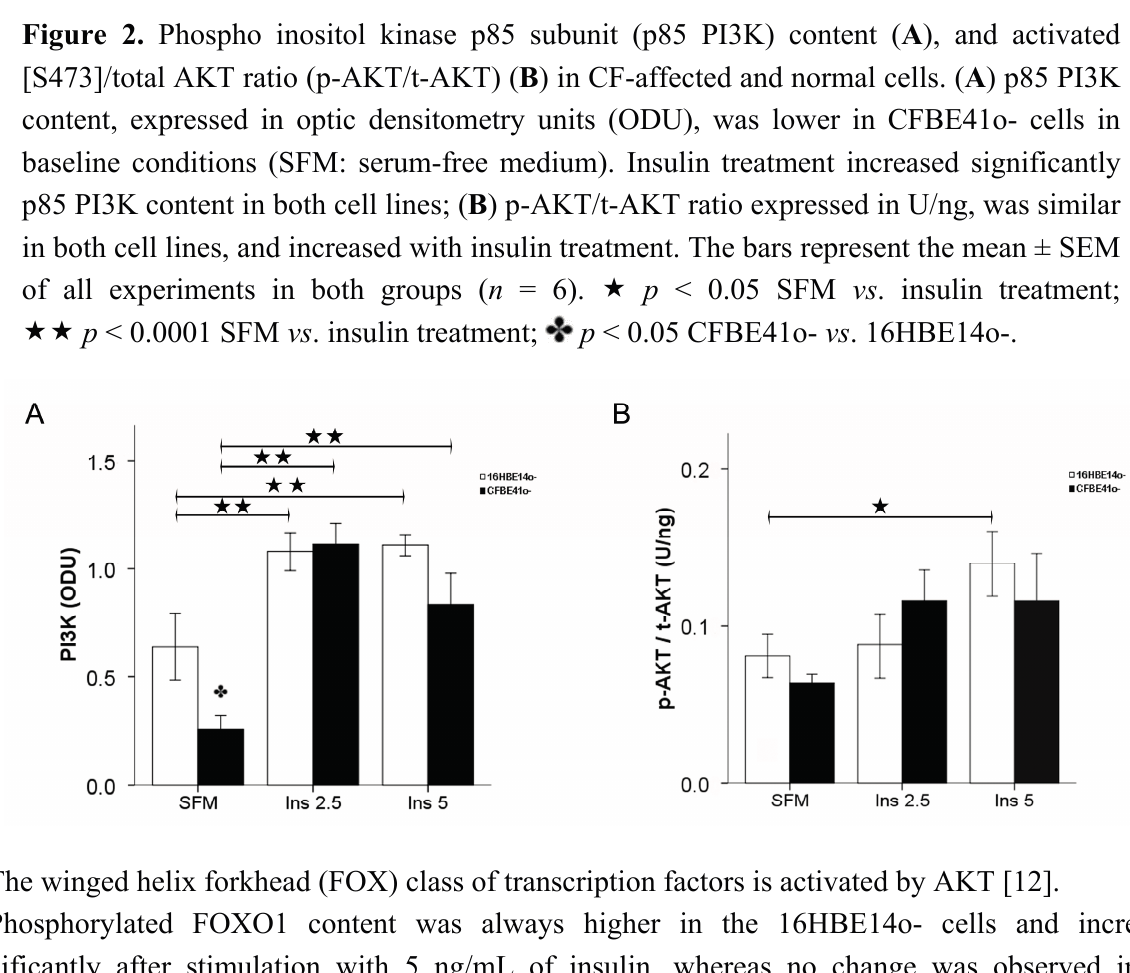
Figure 2. Phospho inositol kinase p85 subunit (p85 PI3K) content ( A ), and activated [S473]/total AKT ratio (p-AKT/t-AKT) ( B ) in CF-affected and normal cells. ( A ) p85 PI3K